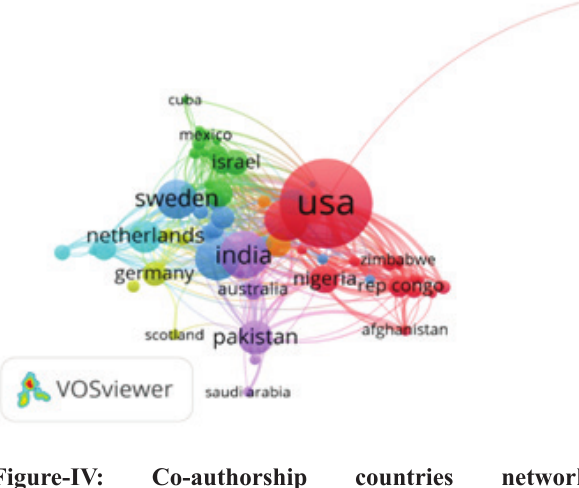
Figure-III: Co-authorship organizations network visualizations mapping.